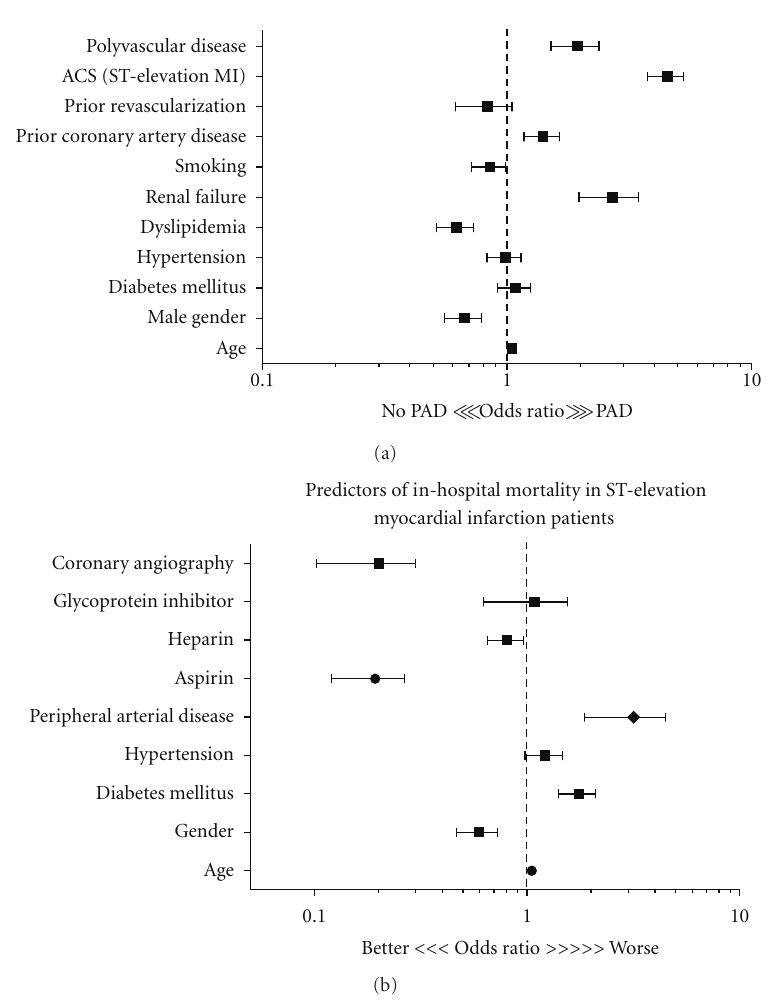
Figure 2: (a) predictors for peripheral arterial disease, (b) clinical predictors for in-hospital mortality in ST-elevation myocardial